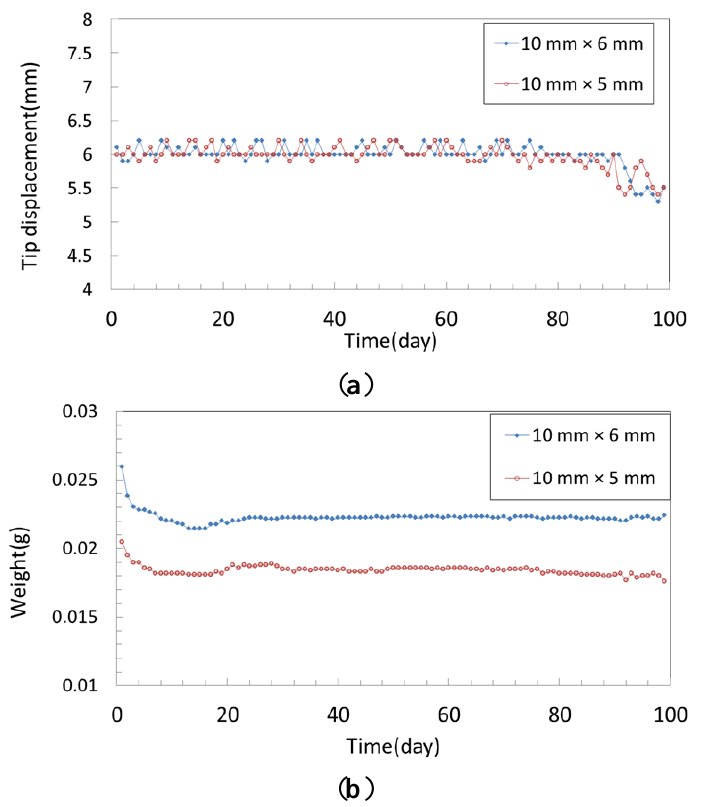
Figure 13. ( a ) Variation in tip displacement of IPMC with propylene carbonate solution. ( b ) Variation in weight of IPMC with propylene carbonate solution.